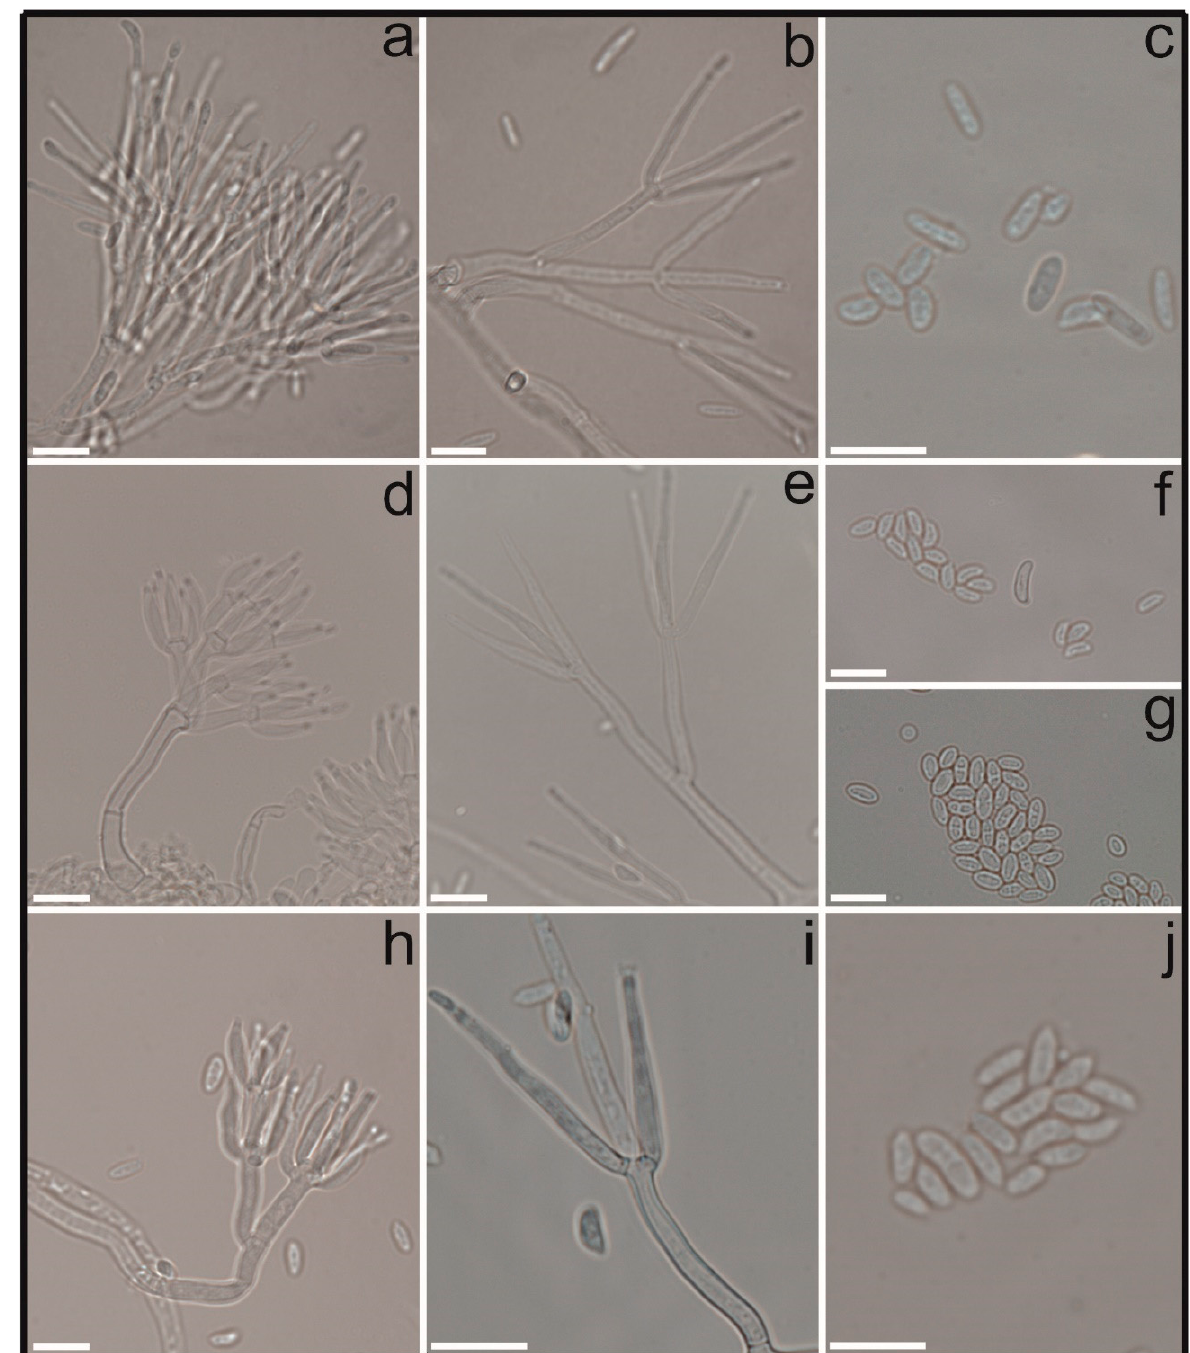
Figure 2. Clonostachys spp. obtained during the survey for fungal antagonists of Hemileia vastatrix ; photomicrographs taken from slide cultures on OA (5–6 days of growth at 25 °C in light/dark-12/12 hs daily light/dark regime). ( a – c ) C. byssicola COAD 2983: ( a ) secondary conidiophore, ( b ) primary conidiophore and ( c ) conidia; ( d – g ) C. rhizophaga COAD 2982 and COAD 2980: ( d ) secondary conidiophore, ( e ) primary conidiophore and ( f , g ) conidia; ( h – j ) C. rosea f. rosea COAD 2984: ( h ) sec- ondary conidiophore, ( i ) primary conidiophore and ( j ) conidia; ( a – c ) COAD 2983; ( d − f ) COAD 2982; ( g ) COAD 2980; and ( h – j ) COAD 2984. Scale bar = 10 µ